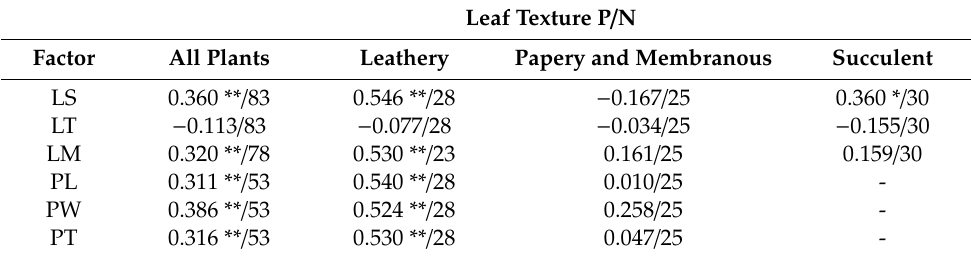
Table 4. Kendall correlation coe ffi cients between the increase in plant leaf vibrational velocity and leaf physical properties.